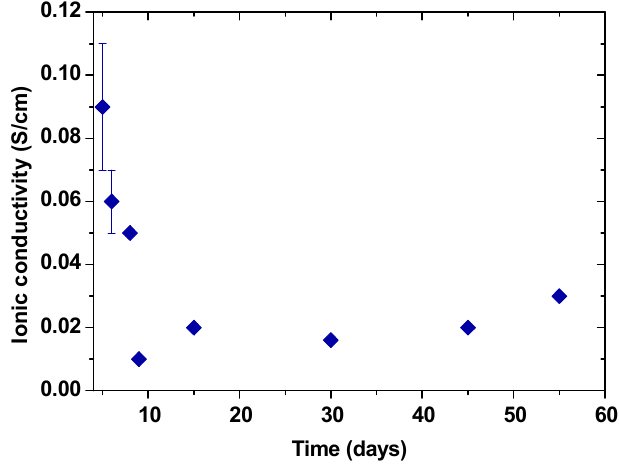
Figure 6. Ionic conductivity evolution of the gel polymer electrolyte over time.